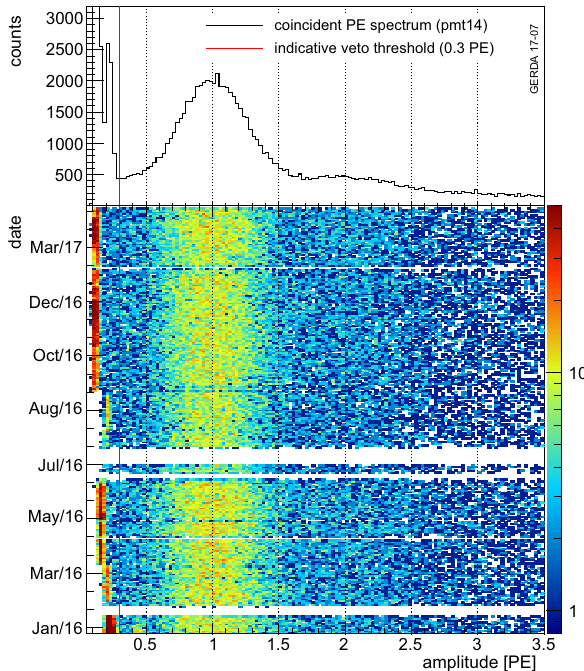
Fig. 25 PulseheightspectrumofaPMT(top)deducedfromthescatter plot (bottom) which has been accumulated between January 2016 and April 2017